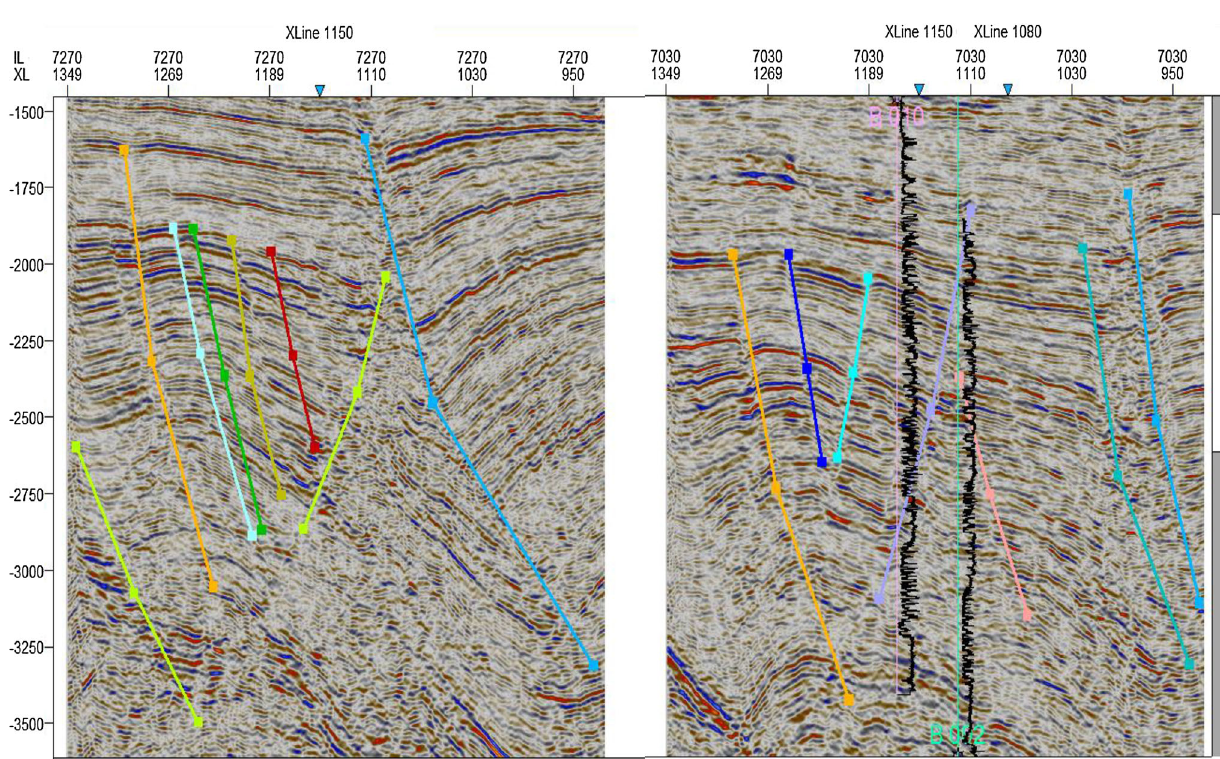
Fig. 8 Fault trends mapped in the study